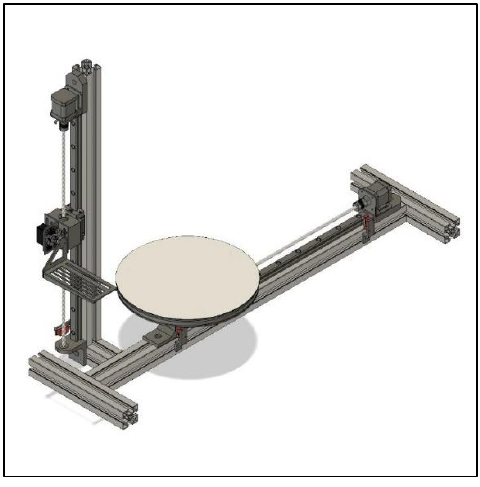
Figure 2. Mechanical design of scanner